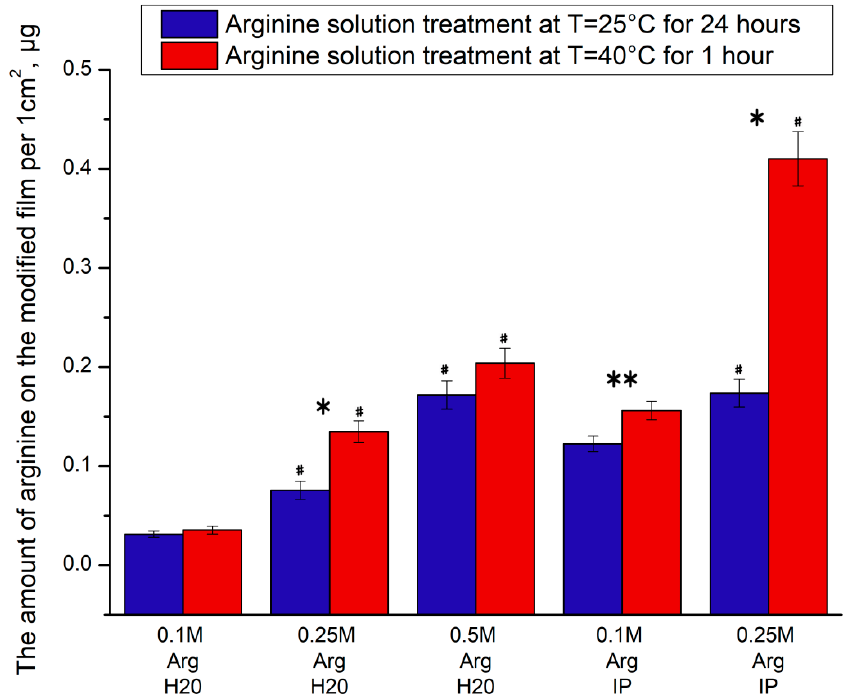
Figure 2. The dependence of the arginine amount on the modified film per 1 cm 2 on the solution concentration (water (H 2 O) or isopropanol (IP)) at T = 40 ◦ C and T = 25 ◦ C. ( n = 5: *— p < 0.02 for the same concentration data, **— p < 0.05; #— p < 0.02 compared with lower concentration, but the same temperature).